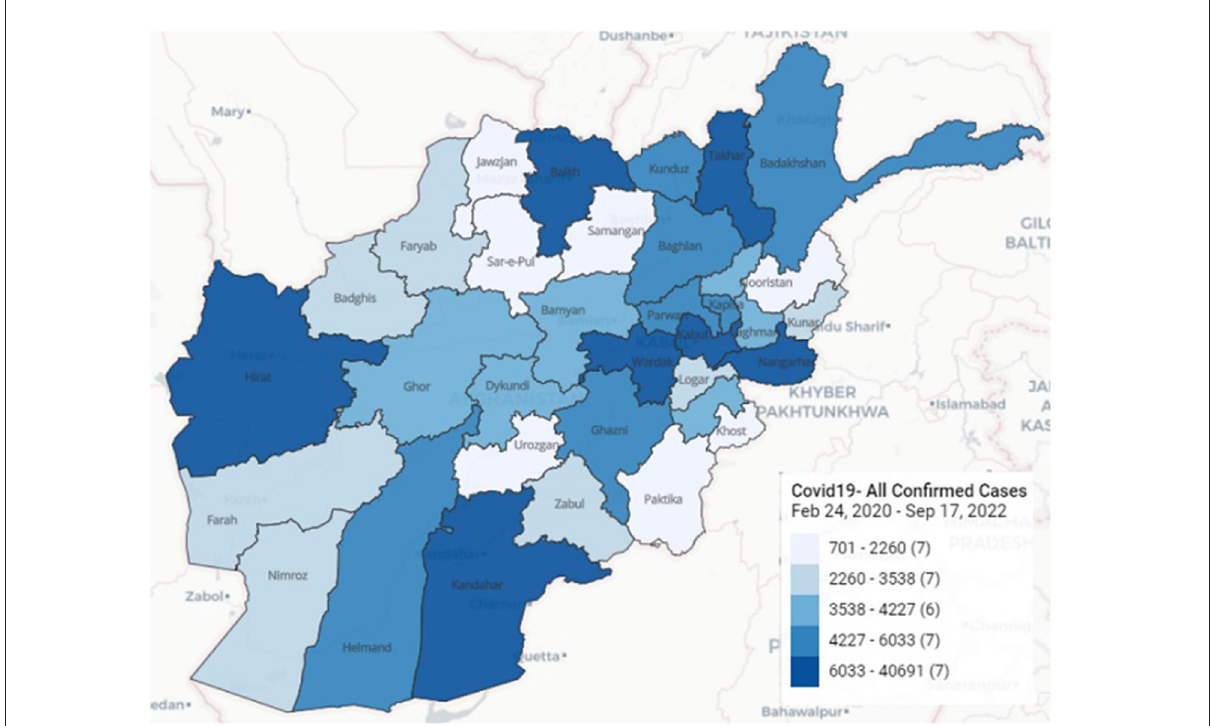
FIGURE1 Geographical distribution of COVID-19 confirmed cases in Afghanistan (24 Feb 2020-17 Sep 2022) (48).